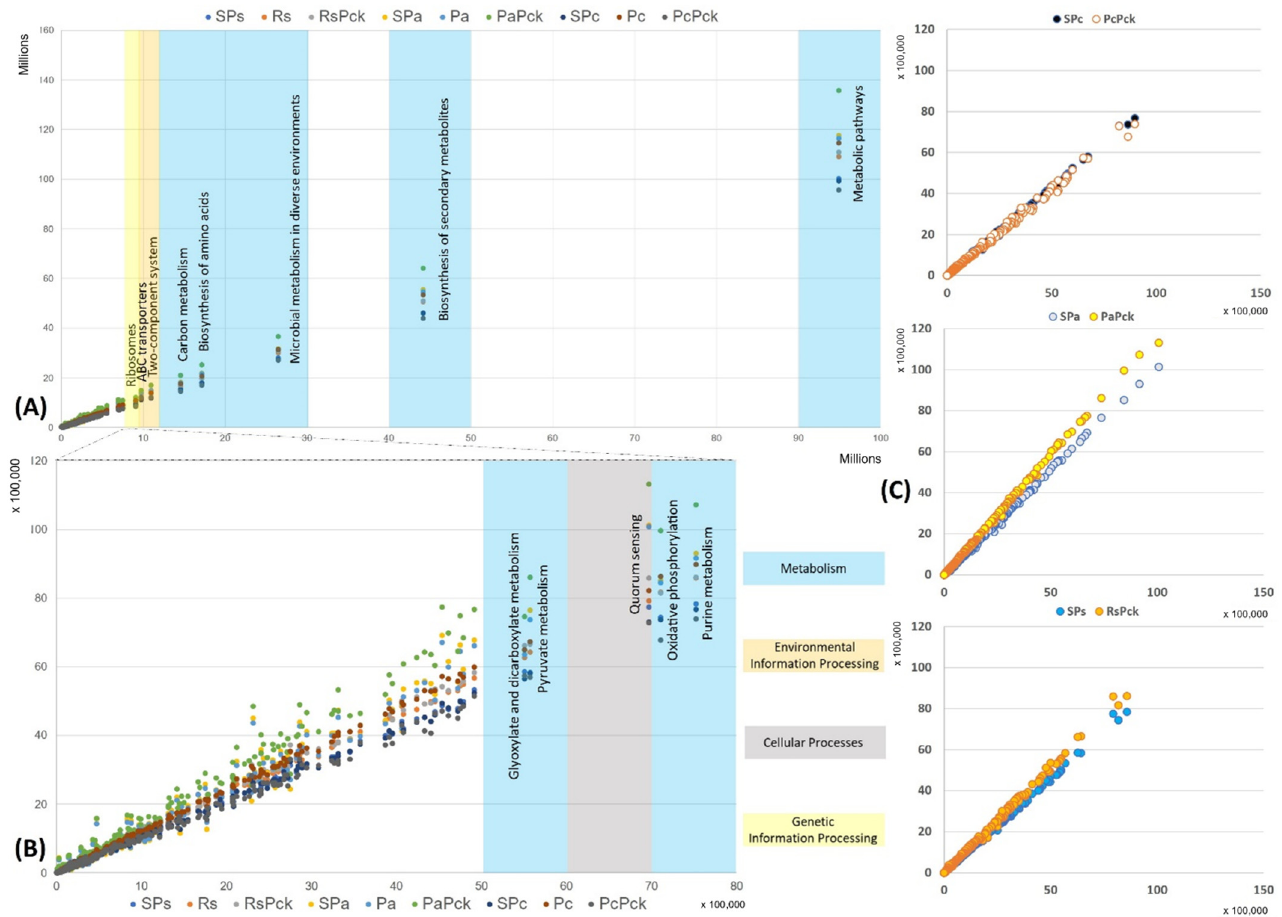
Figure 6. The functional prediction KEGG pathways for all samples at three levels, ( A ) top pathway above 10 million enriched genes, ( B ) between 5500K to 8000K enriched genes and ( C ) the gene enrichment plot of the phage therapy treatments versus the untreated soil.